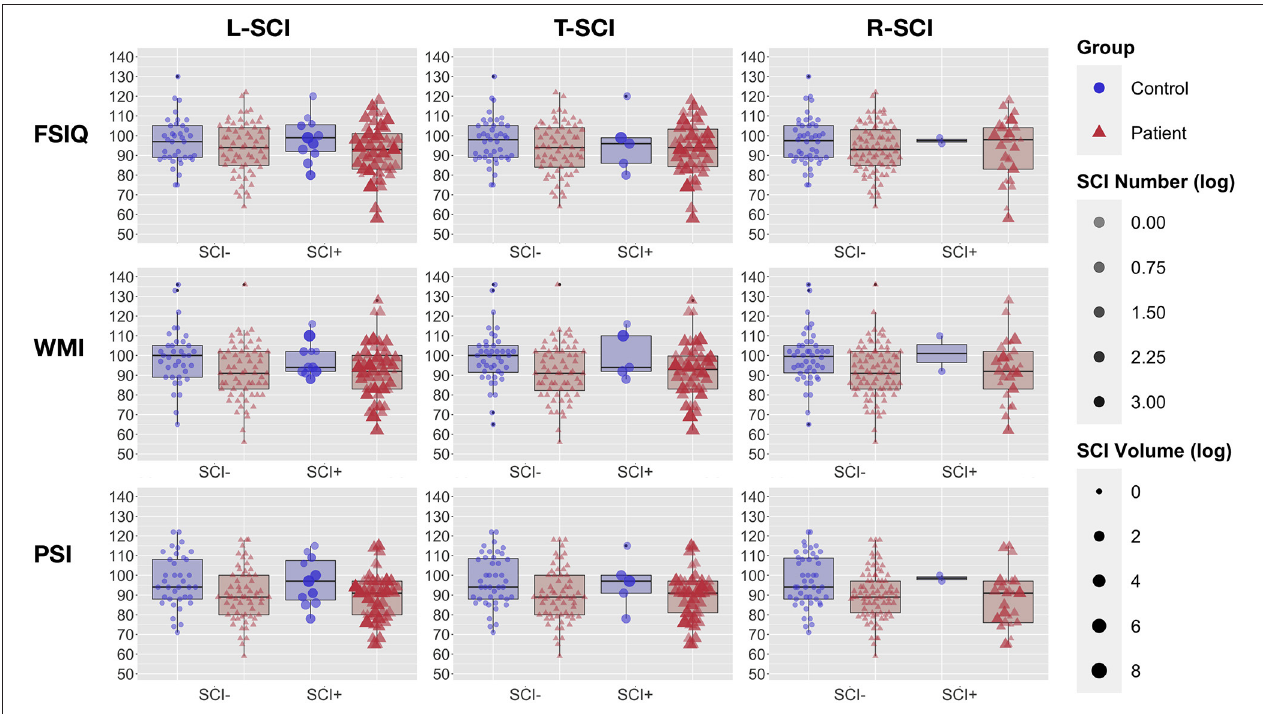
FIGURE 4 | Cognitive Performance and Global Lesion Presence. Showing full-scale IQ (FSIQ: top row), working memory index (WMI: middle row), and processing speed index (PSI: bottom row) in patients with sickle cell anemia (red triangles) and controls (blue circles). Participants are grouped by silent cerebral infarct status (SCI + = with silent cerebral infarction, SCI– without silent cerebral infarction) for the liberal definition (left column), traditional definition (middle column), and restrictive definition (right column). For each definition, point intensity is weighted by the log-transformed number of lesions, and point size by the log transformed volume of